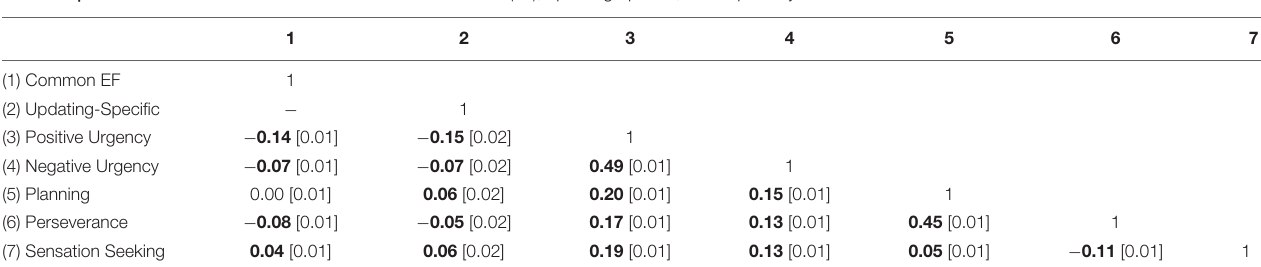
TABLE 4 | Correlations between latent common executive function (EF), updating-specific, and impulsivity